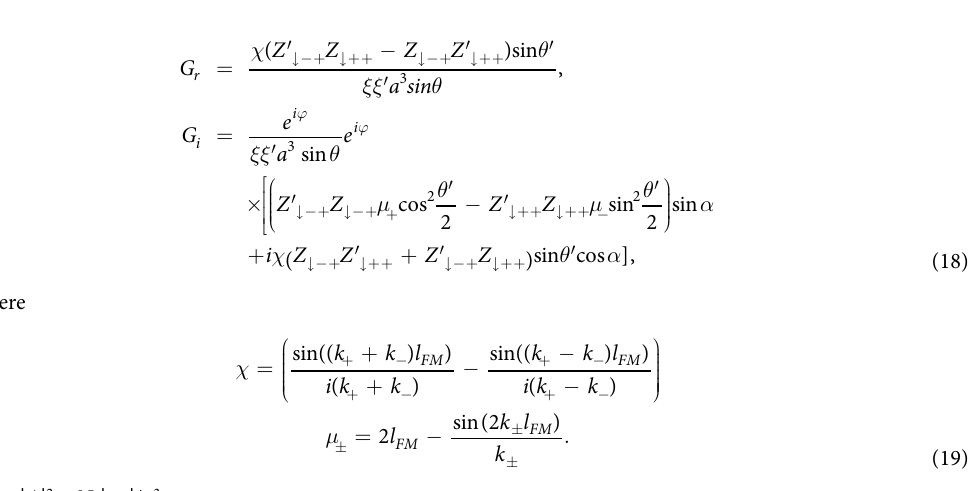
Here | A | 2 = N F | μ 0 |/ a 3 .